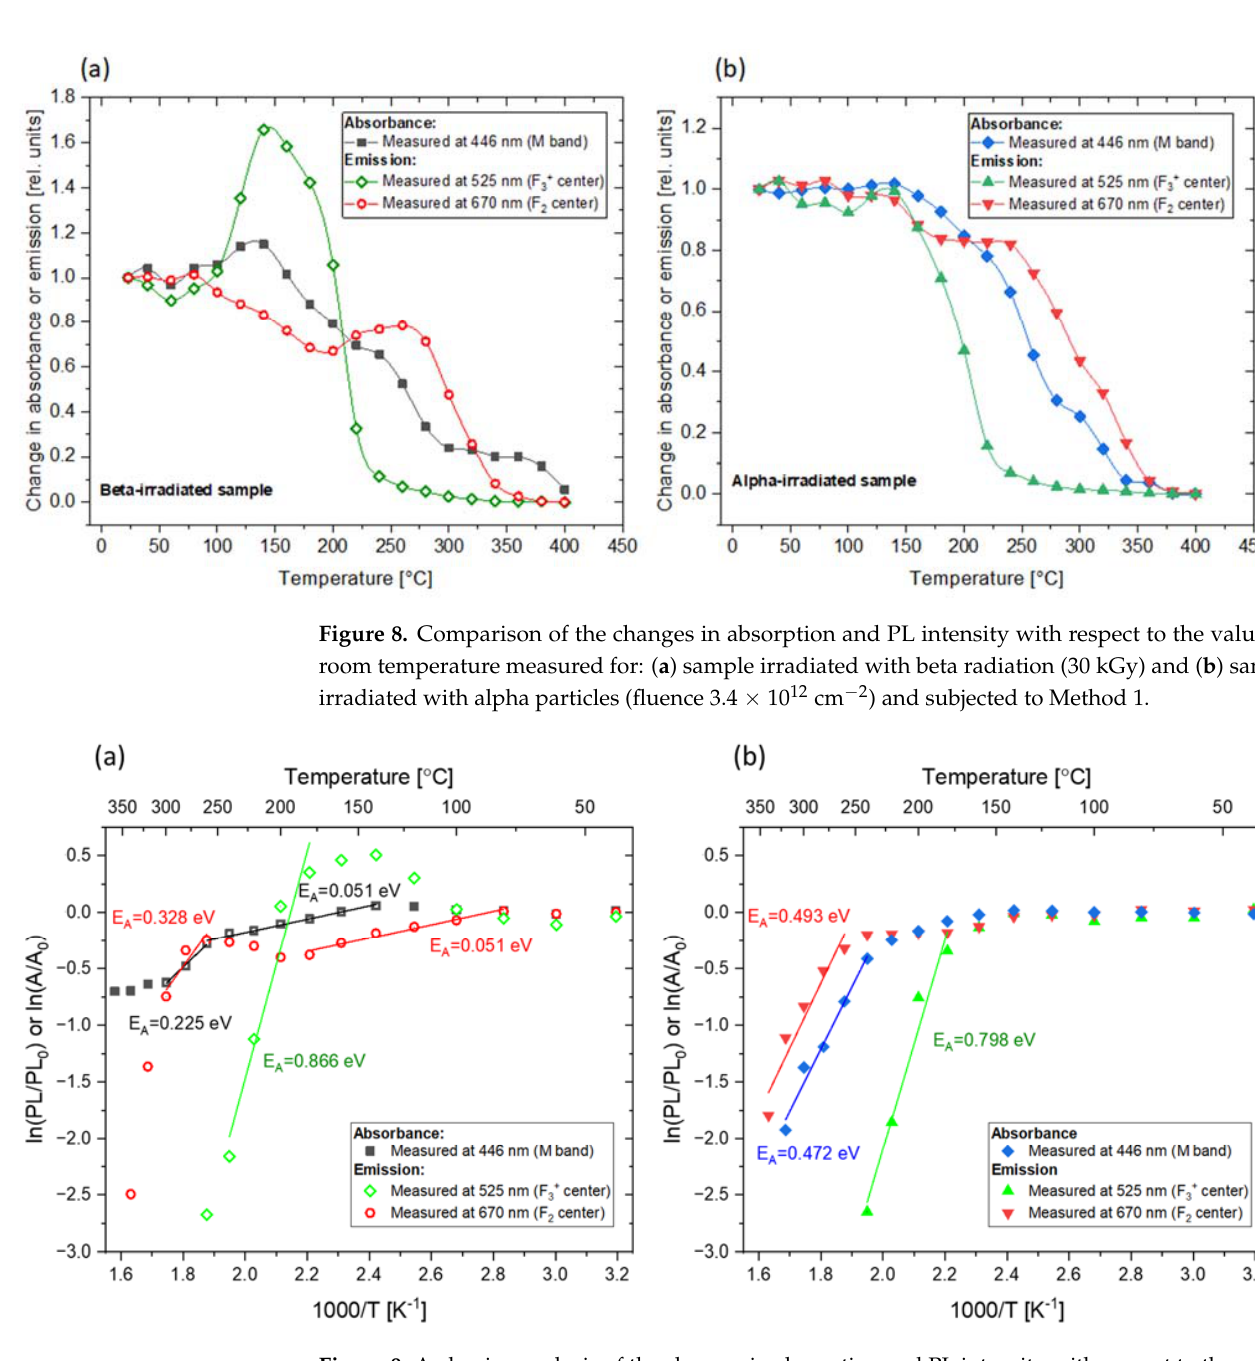
Figure 9. Arrhenius analysis of the changes in absorption and PL intensity with respect to the values at room temperature measured for: ( a ) sample irradiated with beta radiation (30 kGy) and ( b ) sample irradiated with alpha particles (fluence 3.4 × 10 12 cm − 2 ) and subjected to Method 1. For the beta-irradiated sample, the absorbance data measured at 446 nm for tem- peratures above 300 ◦ C were excluded from the analysis. After the heat treatment at these temperatures, there is no distinct peak at 446 nm, but a broad tail extending over a wide range of wavelengths is visible instead (which can be seen in Figure 2, inset). It is most probably not related to the discussed color centers but to other defects instead, e.g., Li colloids